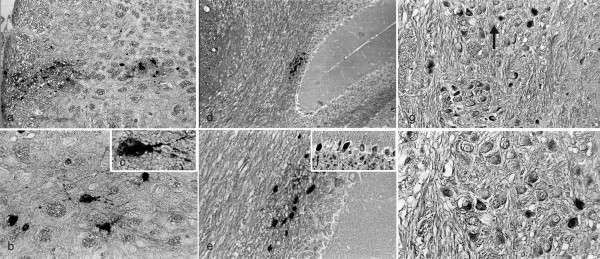
HSV-1 antigen positive cells appear sequentially in non-contiguous areas throughout the brains of BALB/c mice. Ten-12 week ♀ BALB/c mice were infected with HSV-1 strain 2 via the oral mucosa. Three mice were examined every 3 days at necropsy from day 0 through day 30 PI. Serial sections of the brain were examined for viral antigens (IHC) and counterstained with CFV. In representative sections, viral antigen was first identified in the BST on day 3 PI. (a) Viral antigen positive cells in the BST, 3 days PI (x100) (b) Higher power photomicrograph of HSV-1 antigen positive cells on day 3 PI (x400) (c) High power photomicrograph of HSV-1 antigen positive cell with the morphology of a neuron on day 3 PI (x1000). Viral antigen was first identified in the cerebellum (CB) on day 6 PI (d) Viral antigen positive cells in the CB, 6 days PI (x100) (e) Higher power photomicrograph of HSV-1 antigen positive cells on day 6 PI (x400) (f) High power photomicrograph of HSV-1 antigen positive Purkinje cells in the CB, 6 days PI (x400). Viral antigen was first identified in the cerebrum (CR) on day 7 PI (g) Viral antigen positive cells (arrow) in the CR, 7 days PI (x200) (h) Higher power photomicrograph of HSV-1 antigen positive cells with the morphology of neurons in the CR, 7 days PI (X400).